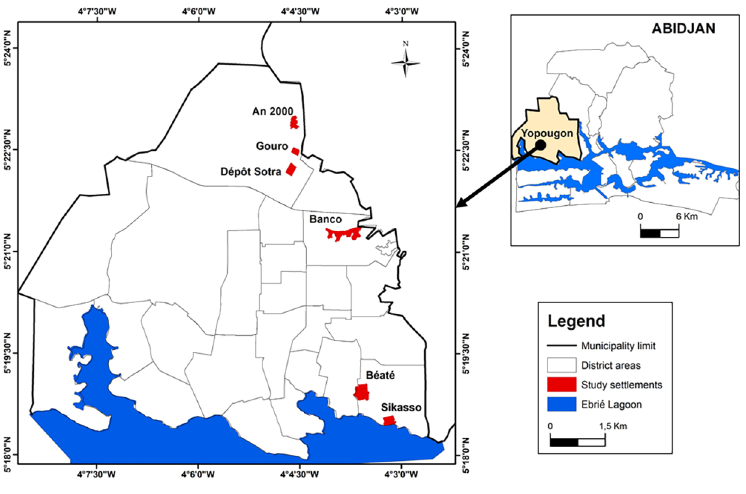
Fig 1. Municipality of Yopougon,